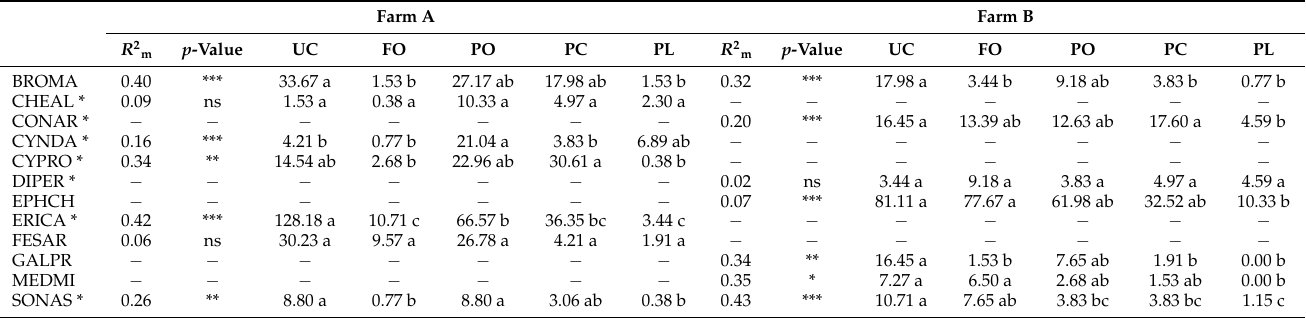
Table 4. Effect of treatments on the density of weeds with a significant occurrence (relative den- sity > 3%). Those species classified as noxious weeds are indicated with an asterisk next to the EPPO code. The percentage of variation in weed density that is explained by the fixed effects of the model is indicated ( R 2 m ). A type III ANOVA was used to calculate the significance level of the effect ( p -values: *** p < 0.001, ** p < 0.01, * p < 0.05, ns not significant), followed by a t -test adjusted with a Bonferroni correction for pairwise comparison. For each farm, treatment means sharing the same letter within each row are not significantly different. Farm A Farm